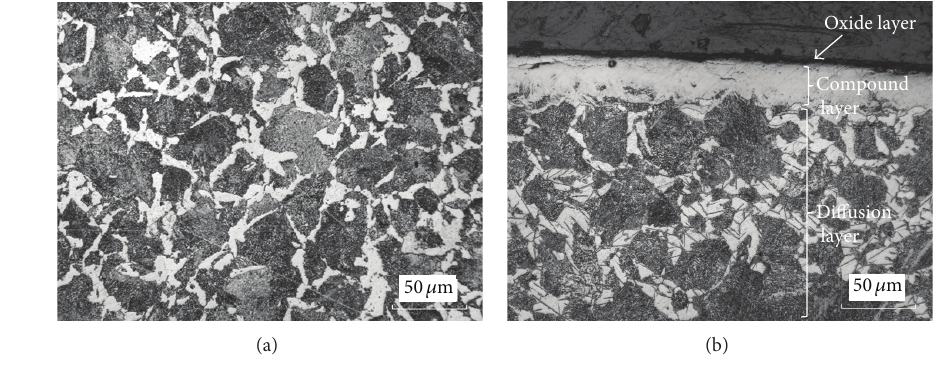
Figure 2: Microstructures of the (a) UCN and (b) CN.